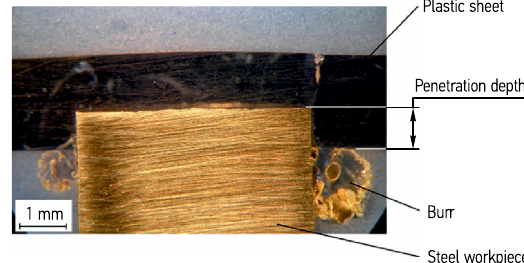
Fig. 3. Typical metal –polymer hybrid joint